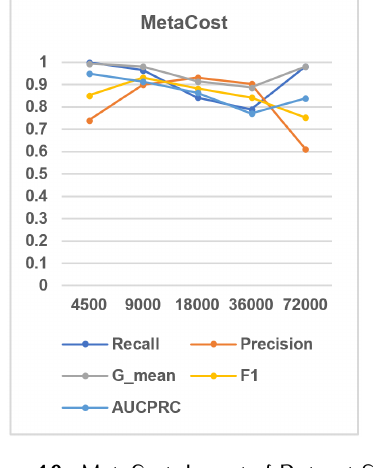
Figure 22. AdaBoost: Impact of Dataset Size